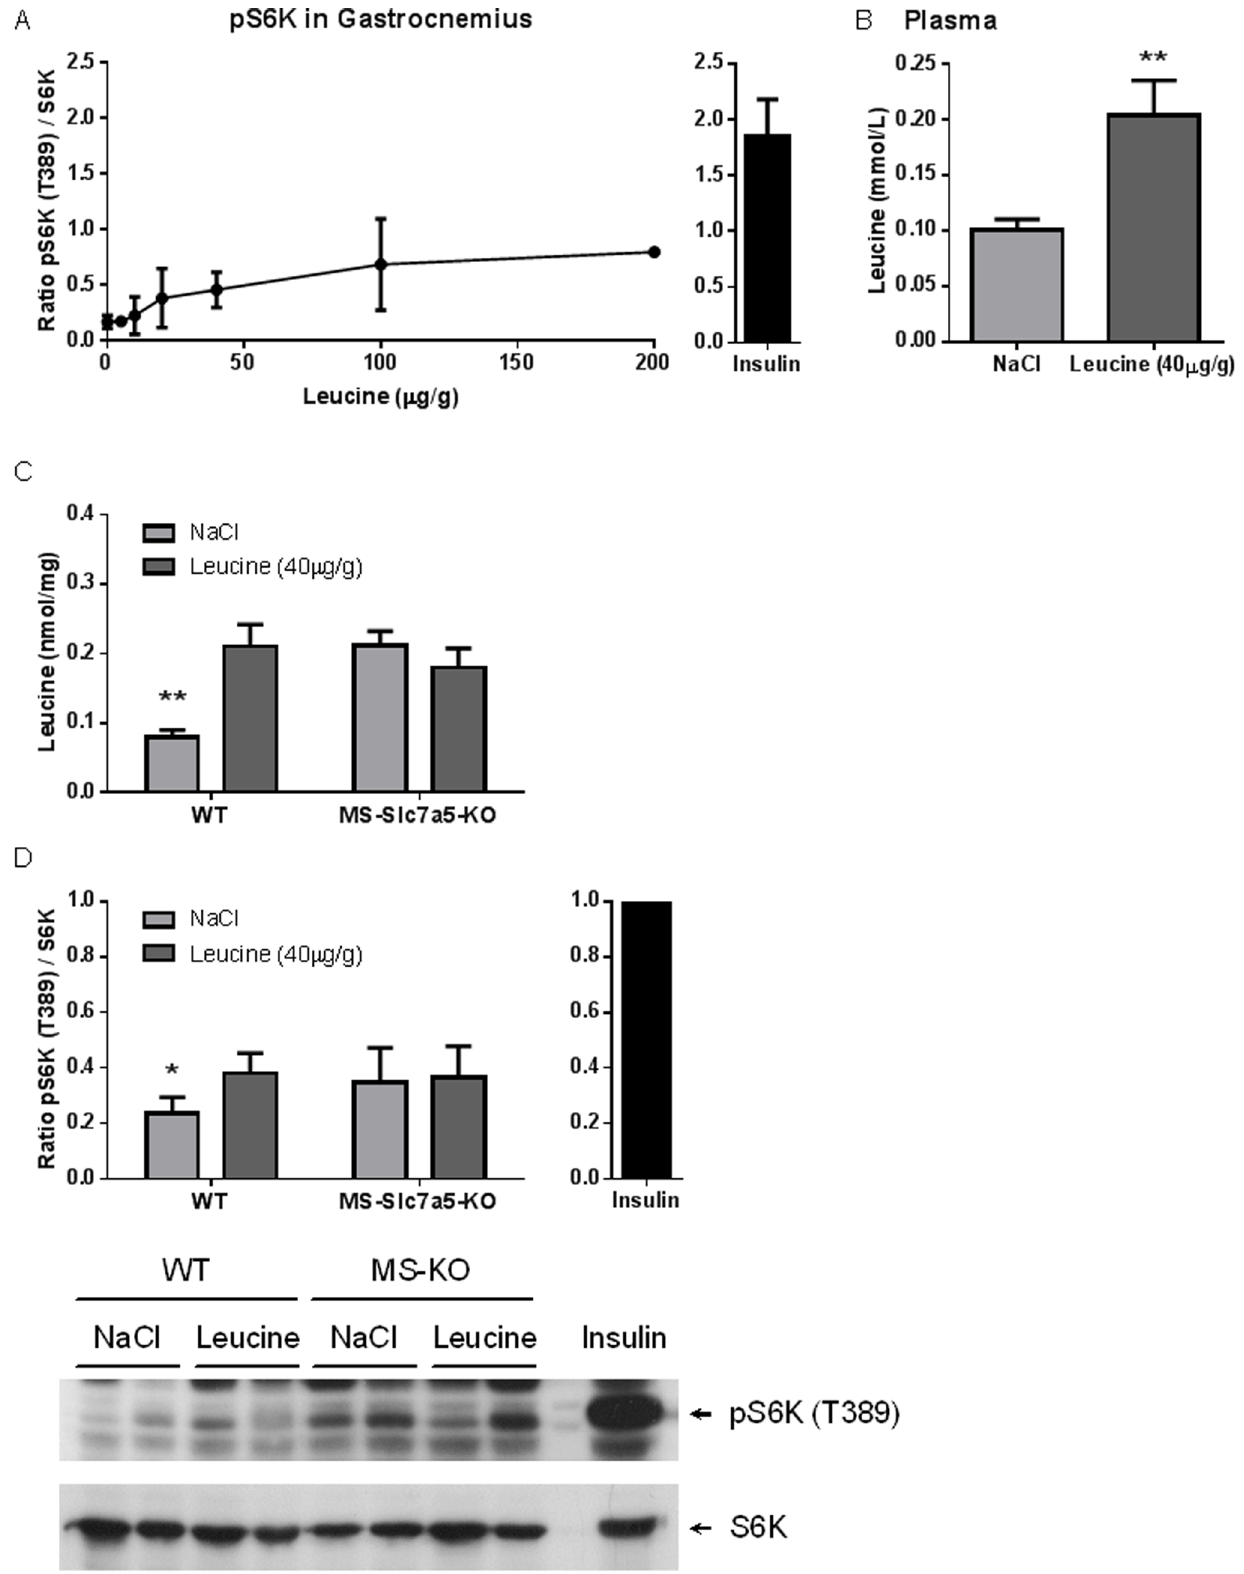
Figure 5. Intraperitoneal leucine injection activates mTORC1 signalling in skeletal muscle. (A) Concentration-dependent effect of I.P. leucine injection on mTORC1-S6K pathway activation in gastrocnemius muscle from fasted wild-type mice, compared to effect of insulin injection (sampling 10 minutes post-injection in all cases) as shown by ratio of pS6K (T389)/S6K. (B) Effect of 40 m g/g leucine injection on plasma leucine